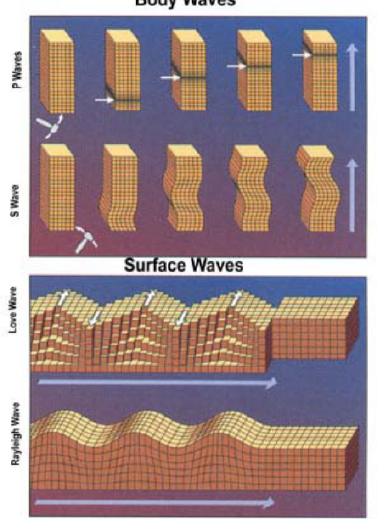
Figure 1. Body and surface waves